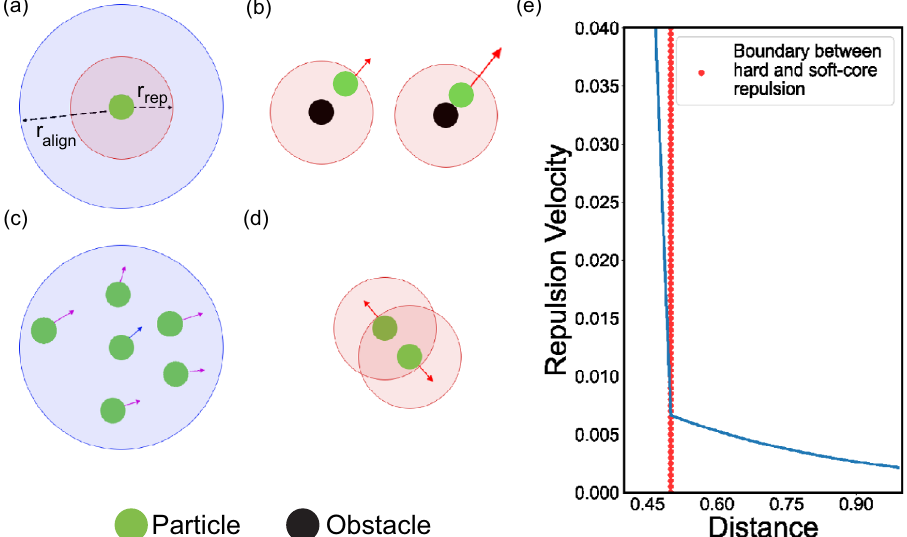
Fig. 1 Visualisation of the main features of the model. Green circles denote particles and black circles denote obstacles a overall view, b visualises particle – obstacle repulsion, c particle – particle alignment and d particle – particle repulsion. The repulsion terms correspond to a sum of hardcore and an exponentially decaying soft term. e illustrates the magnitude of